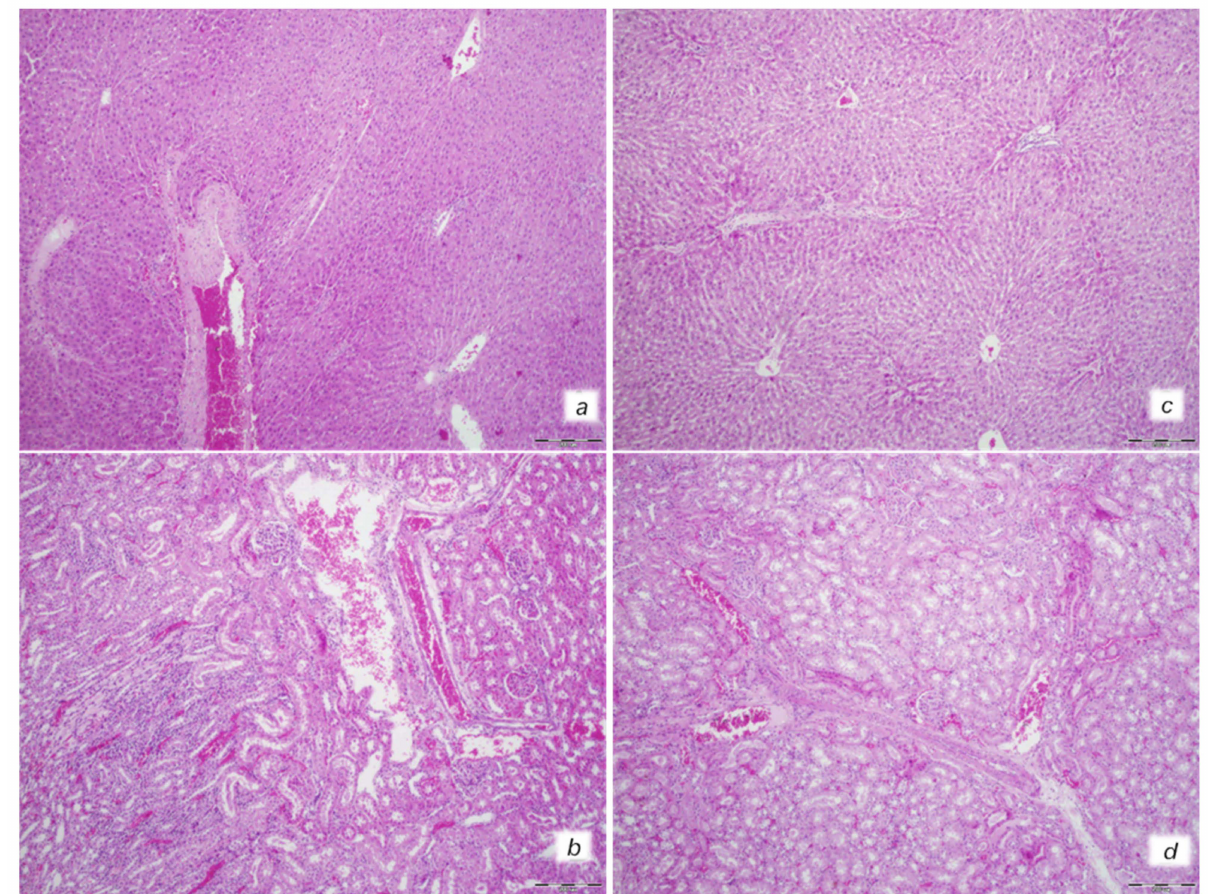
Figure 5. Illustrative features of liver and kidney injury. Isoprenaline 75 mg/kg at 30 min after challenge. Control rats ( a , b ). ( a ) Marked dilatation and congestion of blood vessels in the portal tracts as well as dilatation of central veins and sinusoids. ( b ) Conspicuous dilatation of blood vessels and congestion in the kidney tissue, as well as glomeruli. BPC 157-treated rats ( c , d ). ( c ) No changes in liver tissue. ( d ) Mild dilatation and congestion of blood vessels in the kidney tissue. (HE staining; magnification 100 × ; scale bar 200 µ